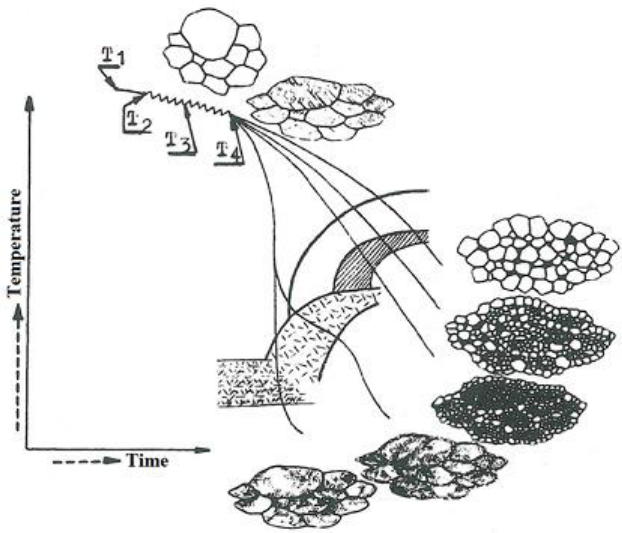
Figure 4. Influence of the cooling rate on the microstructure of steel in controlled rolling